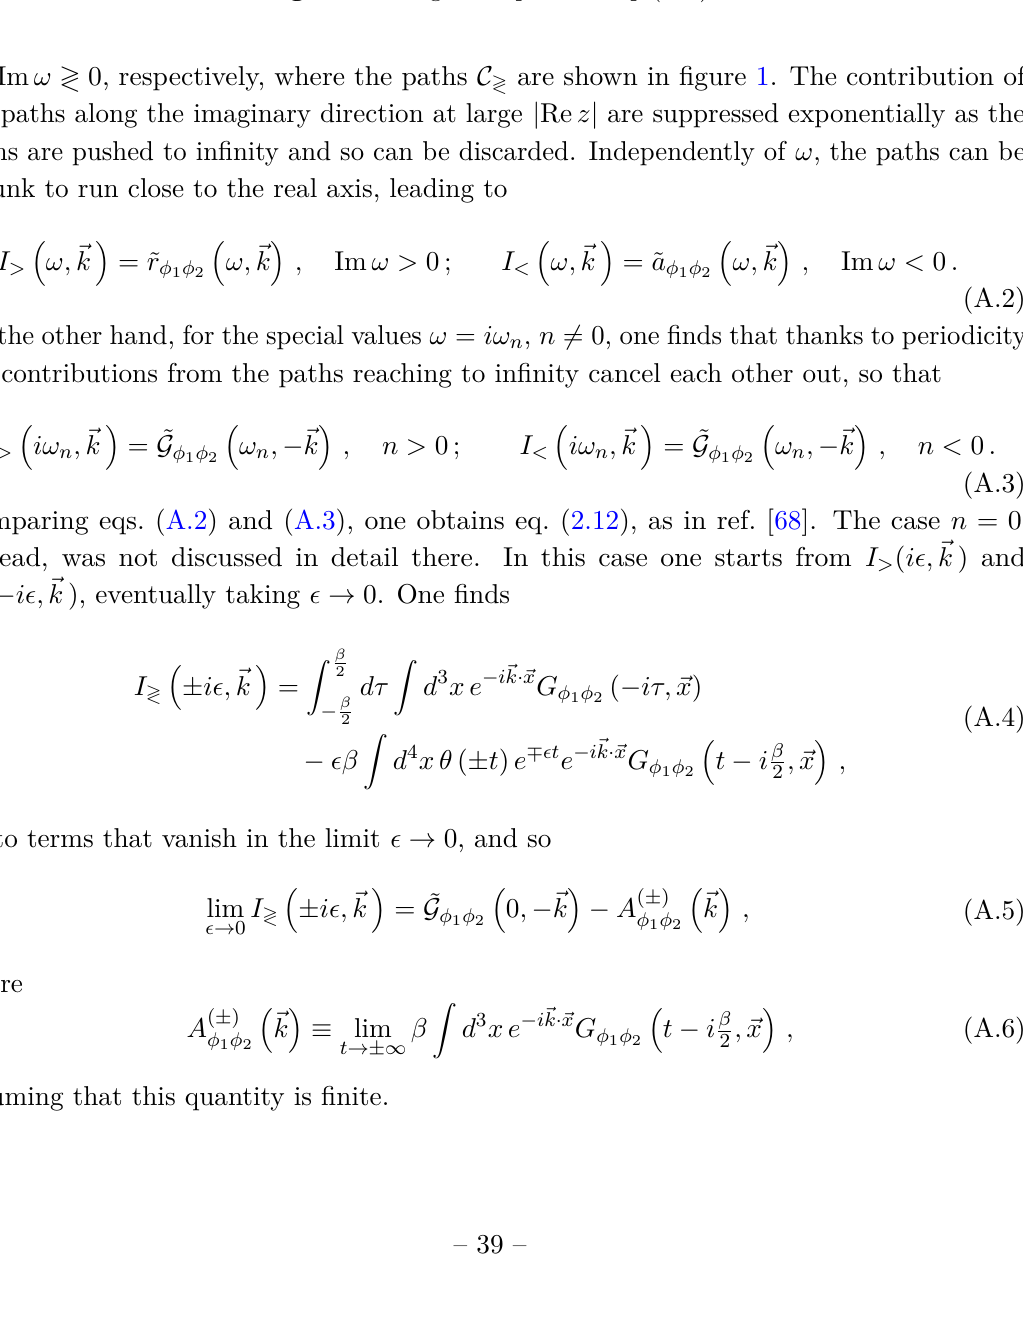
Figure 1 . Integration paths in eq.